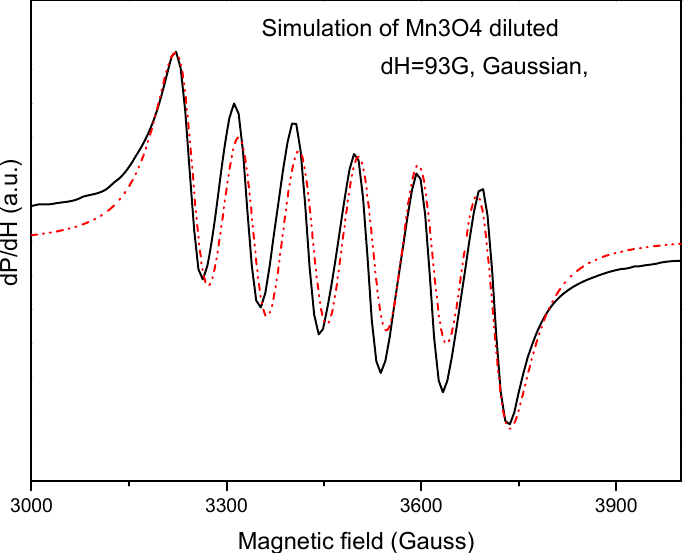
Fig. 3 Room temperature X-band EPR spectrum of diluted Mn 3 O 4 nanoparticles. Dashed line is the simulation by using WinEPR-Sim Fonia